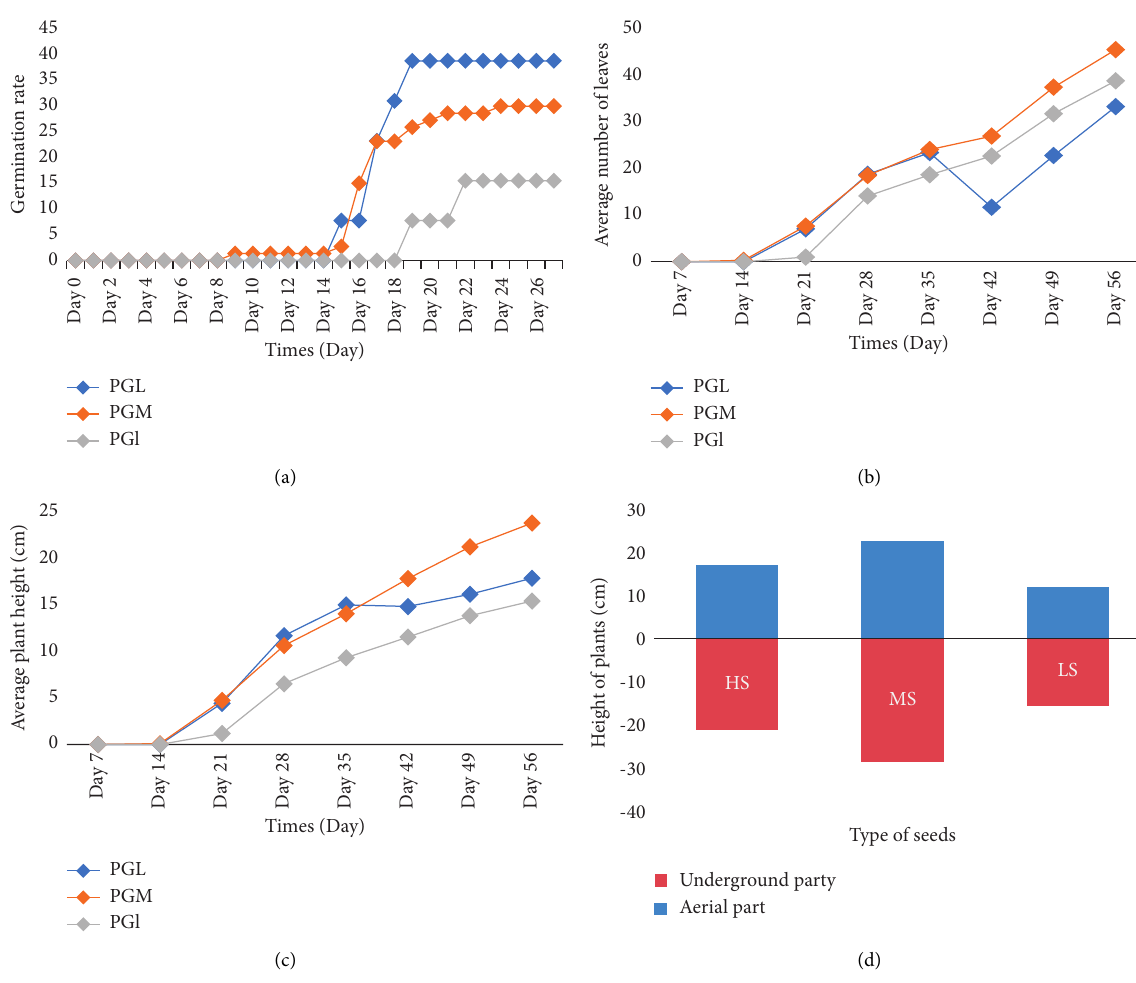
Figure 3: Parameters of growth monitoring of Balanites aegyptiaca at the Regional Centre for Agricultural Research (CERRA), Maradi, Niger. Germination rate (a), evolution of the number of leaves (b), evolution of plant height (c), and final growth of above- and belowground parts of plants (d). PGL: heavy seed, PMG: medium-weight seed, and PGl: Light seeds. Day corresponds to the number of days after sowing the